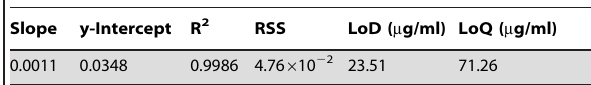
Table 1. Mechanical characteristic of several ground-ended springs inserted into the applicator (means 6 SD, N= 5).